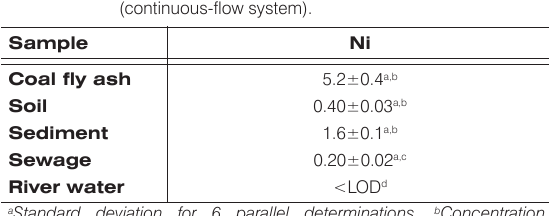
Table 5. Nickel concentration in real samples (μg g -1 or μg mL -1 ) (continuous-flow